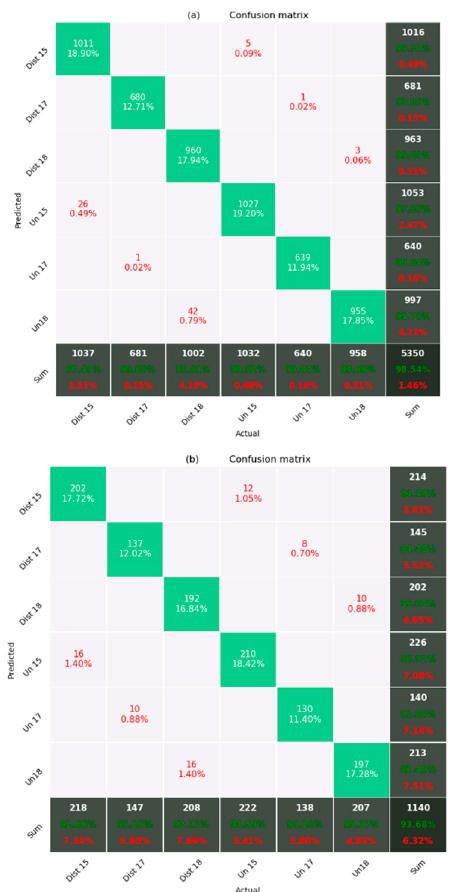
Figure 5. Confusion matrix for Random Forest classification of ( a ) Sentinel-2 and ( b ) Landsat images showing pixel numbers and, in Sum row and column, classification accuracies. Numeric labels represent disturbance year (e.g., 15 = 2015.) Class label abbreviations are: Dist = disturbed OGF, Un = Undisturbed OGF.